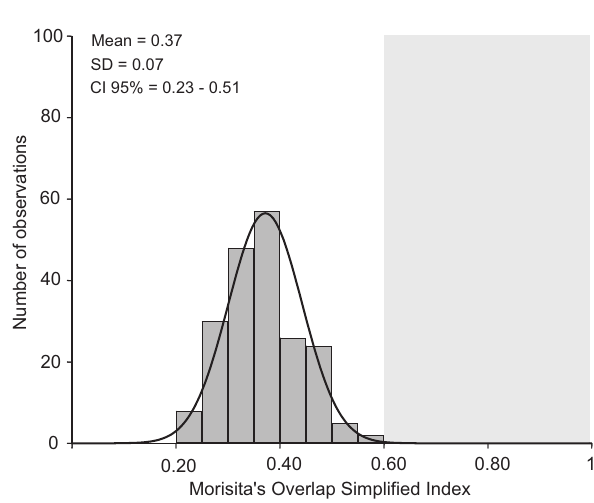
Figure 7. Results of the Bootstrap technique applied to juvenile Menticirrhus americanus and M. littoralis during the summer of 2001/2002. The graph informs the distribution of the 200 gener- ated indexes, with their respective means, standard deviations and 95% confidence intervals. The grey area indicates biologically sig- nificant overlap